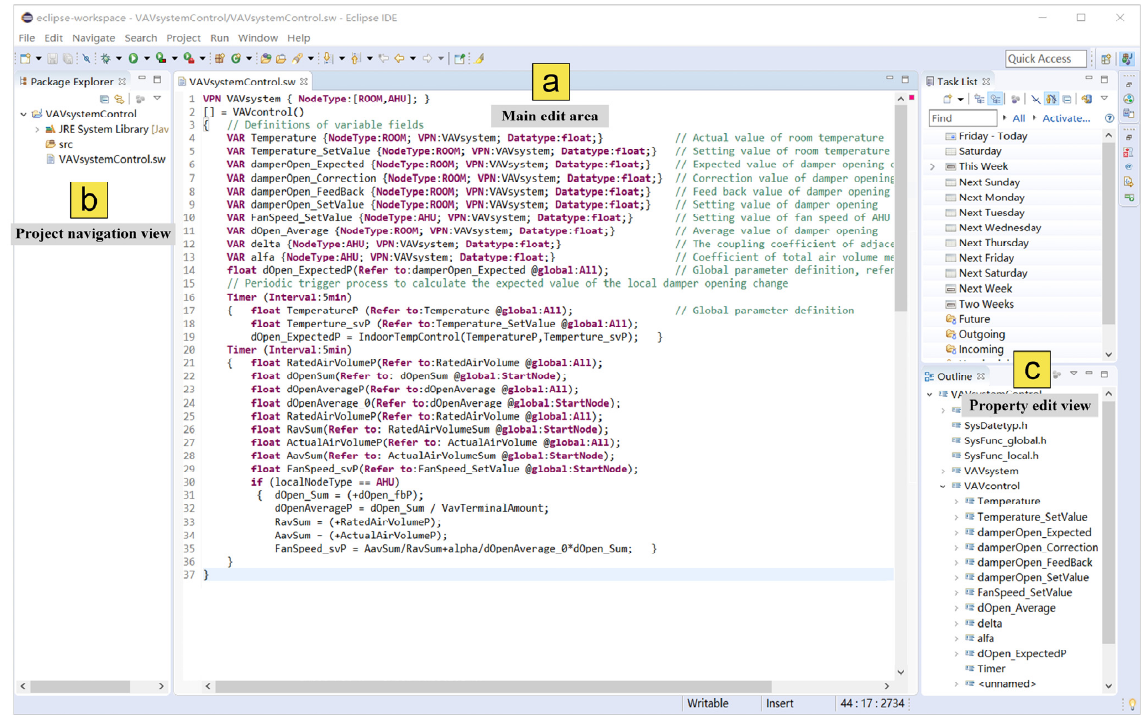
Figure 12. The graphical user interface of SwDET.